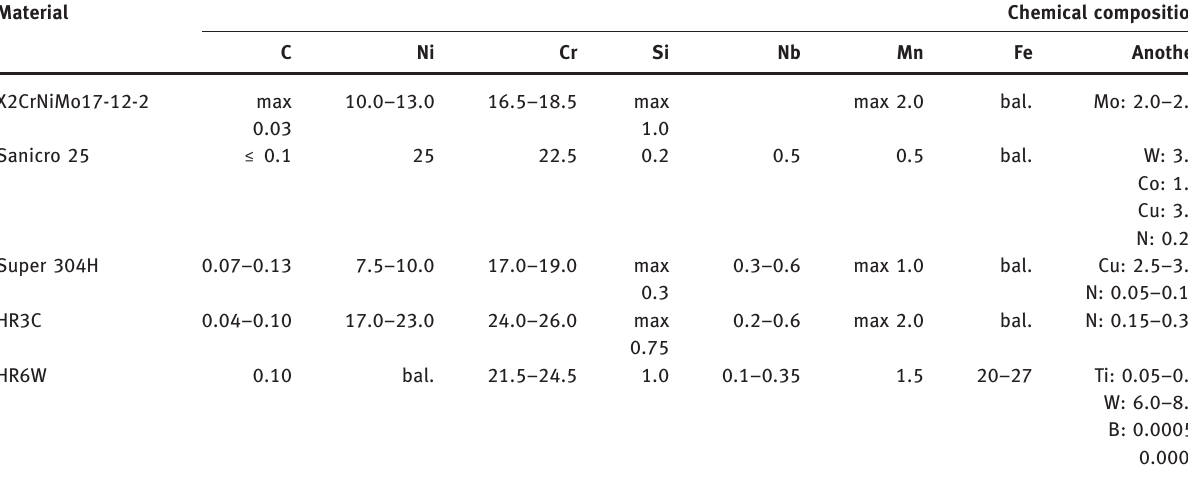
Table 1: Chemical composition of tested materials (mass %).